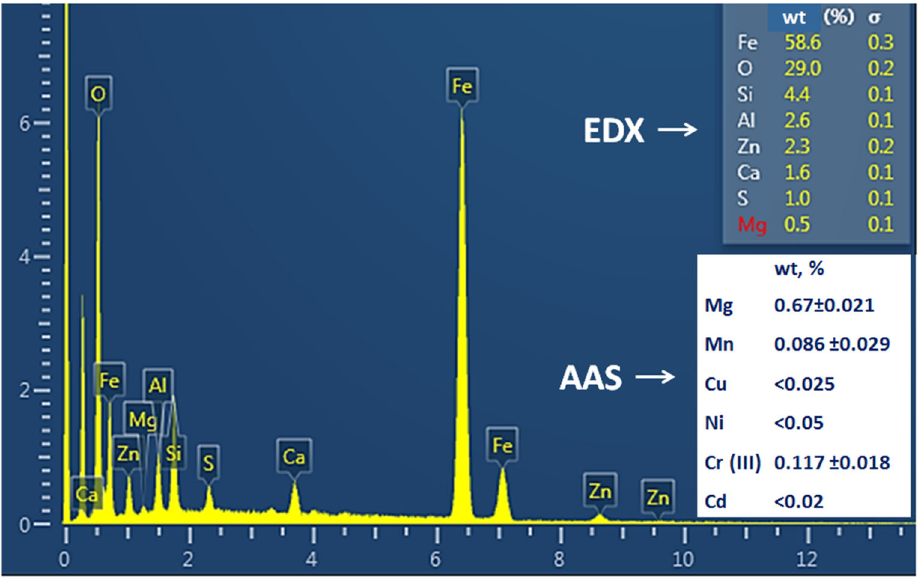
Figure 4. Elemental composition of the sludge: energy-dispersive X-ray spectroscopy (EDX) and atomic absorption spectrometry (AAS).